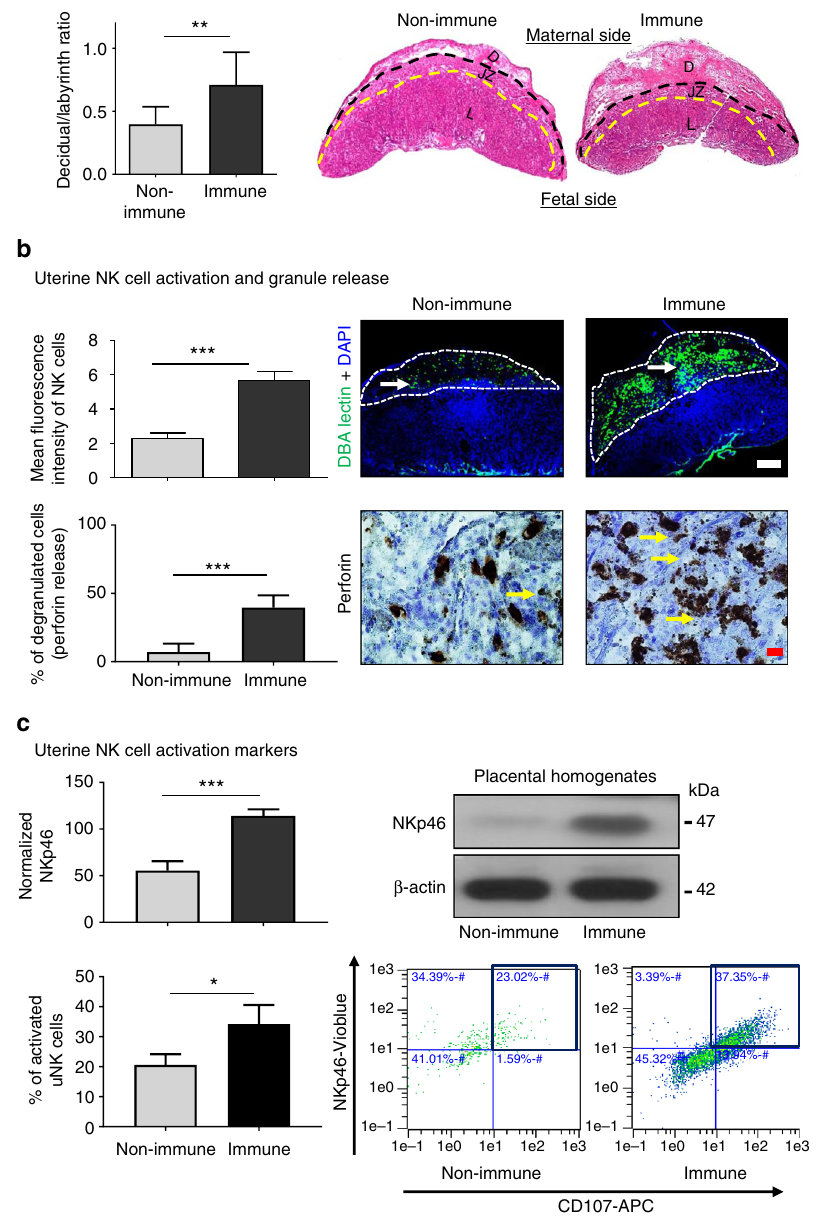
Fig. 3 Placental pathology and NK cell accumulation in the decidua. a At E14.5, implementation sites from immune mice exhibited signi fi cantly enlarged decidua compared to non-immune mice placentas ( top panel ). The decidua/labyrinth ratio was signi fi cantly higher in placentas of immune mice. b DBA + NK cell number remained signi fi cantly elevated at E14.5 ( right top , immuno fl uorescence panel ) and their perforin granules were released ( right bottom , histology panel , degranulated NK cells, yellow arrow ). c NKp46 expression was signi fi cantly upregulated in placentas from immune mice ( top panel ). Percentage of activated uNK cells expressing markers of degranulation such as CD107 (DBA + NKp46 + CD107 + cells) are signi fi cantly increased in immune mice ( bottom panel ). Data were collected from more than eight pregnancies per group. D decidua, JZ junctional zone, L labyrinth. Unpaired Student ’ s t -test. Mean ± SEM. * p < 0.05, ** p < 0.01 and *** p < 0.001. Scale bars : ( b ) 500 μ m white color and 20 μ m red